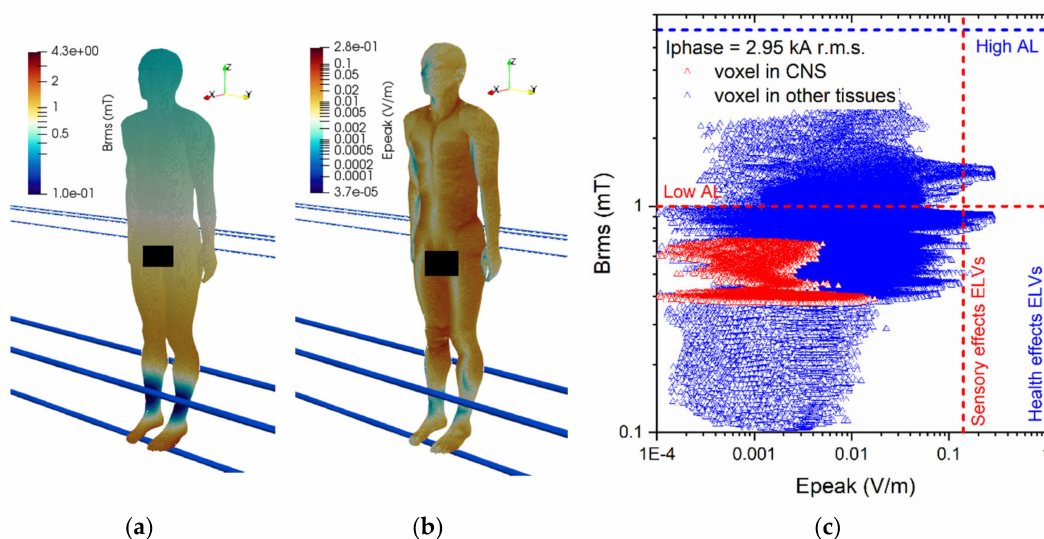
Figure 6. Results for posture A.1. On the left ( a ) the spatial distribution of the B-field amplitude (r.m.s. values in millitesla) over the body surface. In the middle ( b ) the corresponding spatial distribution of the E-field amplitude (peak values in volt per metre) over the body surface. On the right ( c ) the distribution of the voxel values.